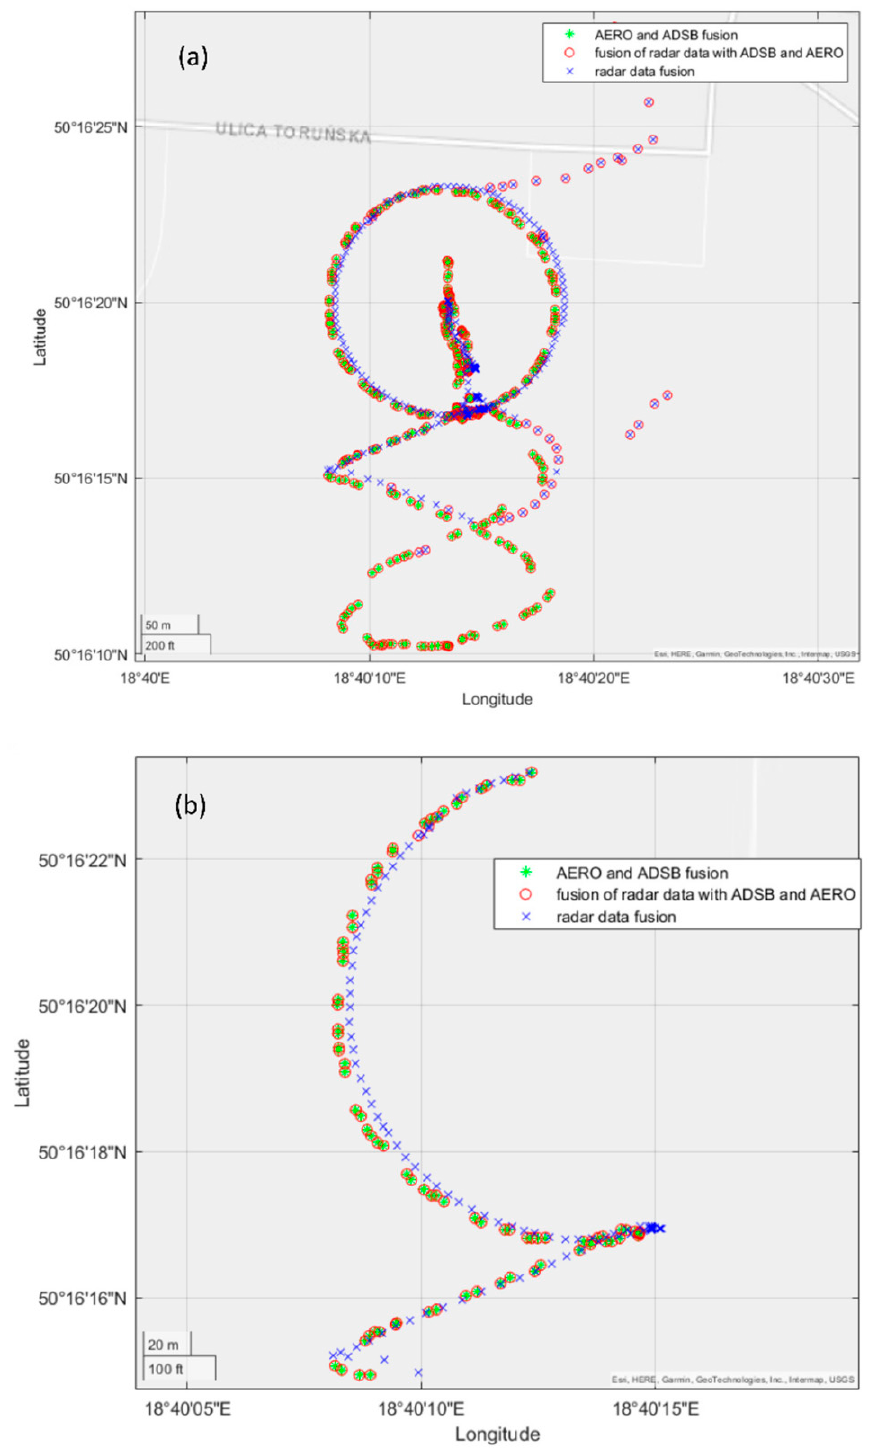
Figure 10. UAV flight path presented in 2D geographical coordinates ( a ) and its enlarged part ( b ). On the other hand, the UAV flight path registered by transponder systems ADS-B and AREOSCOPE after the fusion process is plotted with a red circle. As one can notice by looking at this picture, there is a slight offset between the transponders’ and radar’s data regarding the flight altitude measurements. This phenomenon is illustrated more precisely in Figure 11. The reason for such a discrepancy in the presented results comes from the fact that the assembly offsets of the radar antennas were not measured precisely